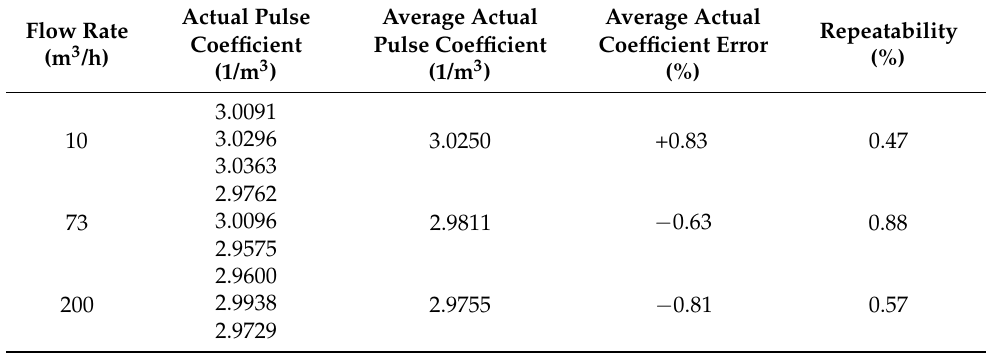
Table 3. Experimental results of unstable flow field experiment of the DN50 curved